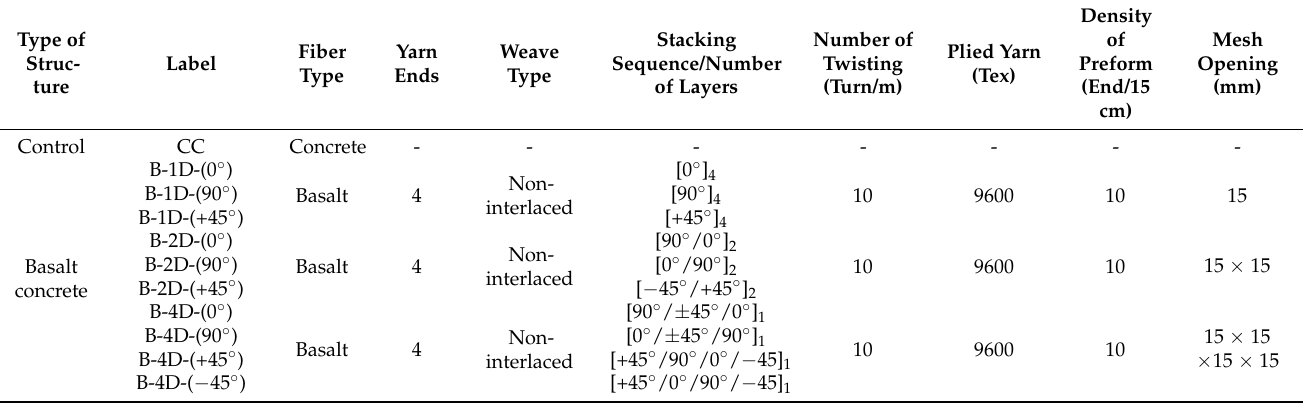
Figure 1. Schematic and actual multiaxis 3D basalt preforms for concrete using the winding-molding method. ( a ) Basalt uniaxial preform (B-1D); ( b ) basalt biaxial preform (B-2D); ( c ) basalt multiaxial preform (B-4D) (digital image). Table 2. Various multiaxis 3D basalt preforms for the